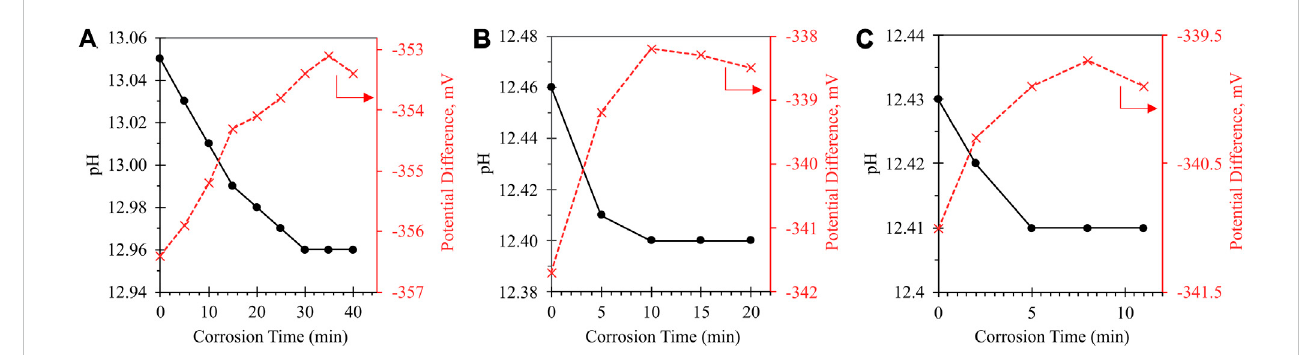
FIGURE 1 Impact of sonication on corrosion time of Al 0 : (A) Room temperature (20 ° C – 22 ° C) with no sonication; (B) 40 ° C with no sonication; (C) 40 ° C with sonication. Solid curve with black circle markers refers to calibrated pH value (primary y -axis); dashed curve with red X markers refers to raw potential difference measured by pH electrode (secondary y -axis). Variations in the absolute value of the y -axes between samples are attributable to the temperature difference between calibration and testing conditions, as the pH meter was calibrated at room temperature prior to each round of